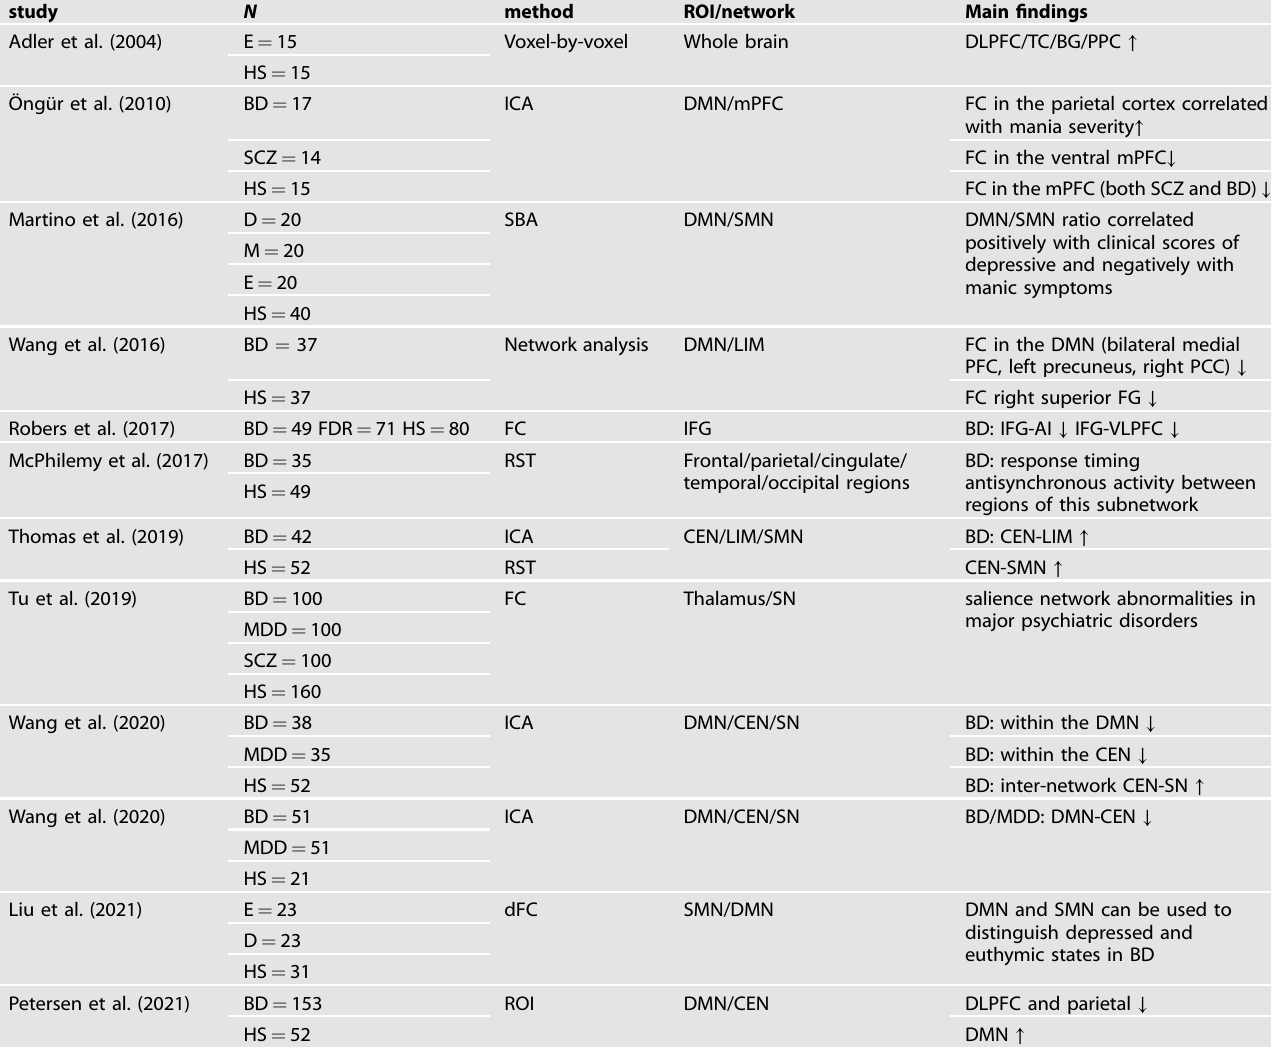
Table 3. Studies exploring the cognition function with fMRI in bipolar